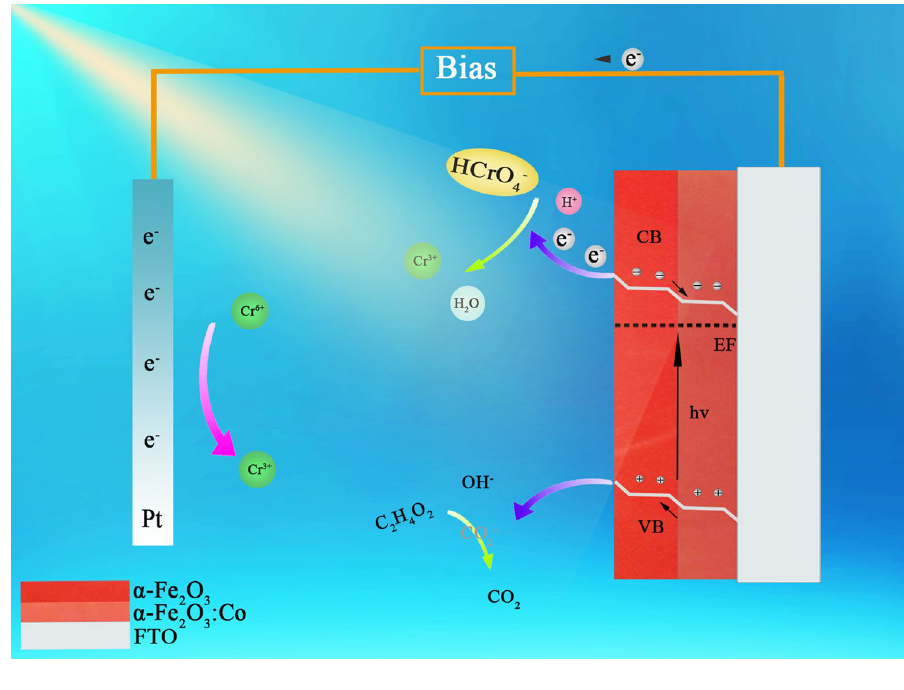
Fig. 6 Schematic diagram of double-layer photoelectrode enhancing chromium reduc-